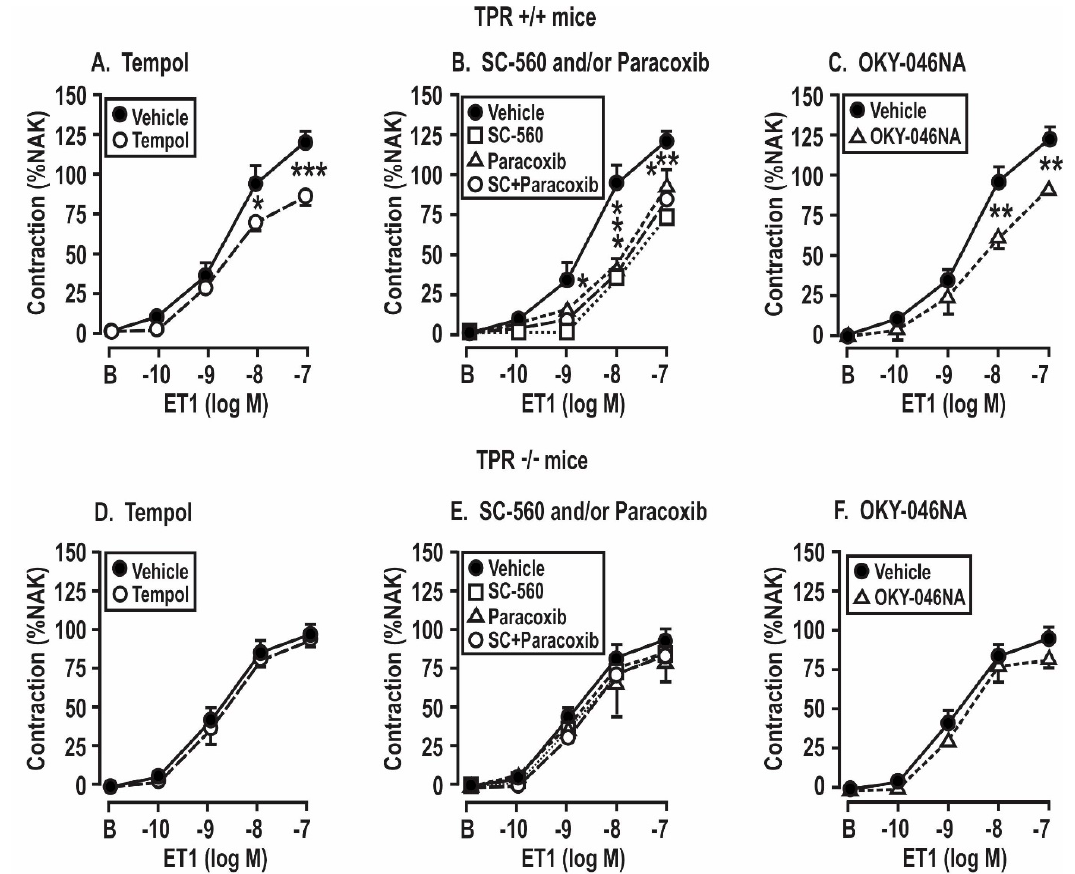
Figure 6. Contractions to endothelin 1 in mesenteric resistance arterioles from mice infused with angiotensin II at 400 ng·kg –1 ·min –1 × 14 days are reduced by the metabolism of reactive oxygen species (A, D) or by the blockade of cyclooxygenase (COX) 1 and 2 (B, E) or thromboxane synthase (TxA 2 S, C, E) but the effects are lost in vessels from thromboxane prostanoid receptor (TPR) − / − mice. Mean ± SEM values ( n = 6 per group) for the vascular contractions to endothelin 1 in wild type (+/+) and thromboxane prostanoid receptor knockout ( − / − ) mice. B, before; % NAK, percent of the response to a standard vascular contraction with norepinephrine and high KCl solution. Comparing groups: *, P < 0.05; **, P < 0.01; ***, P < 0.005. The control data are reproduced from Figure 4.